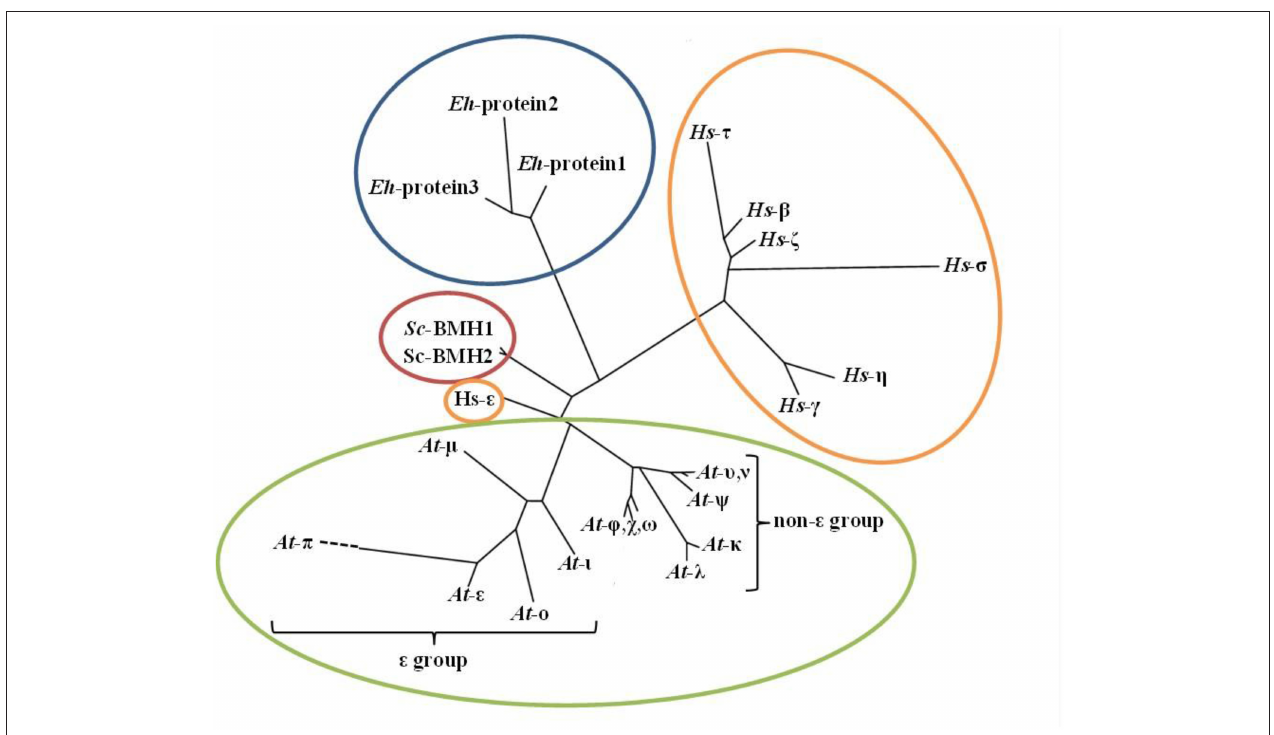
FIGURE 1 | Phylogenetic tree of 14-3-3 paralogs from eukaryotic species. The depicted species are (1) Plantae; Arabidopsis thaliana (mouse-ear cress), (2) Animalia; Homo sapiens (human), (3) Fungi; Saccharomyces cerevisiae (baker’s yeast), (4) Protista; Entamoeba histolytica. Arabidopsis 14-3-3 isoforms are divided into two distinct subgroups: epsilon ( ε ) and non-epsilon. The phylogenetic tree was generated with the Phylogeny.fr program (http://www.phylogeny.fr/) tree-style phylogram, using the full-length 14-3-3 protein sequences from each